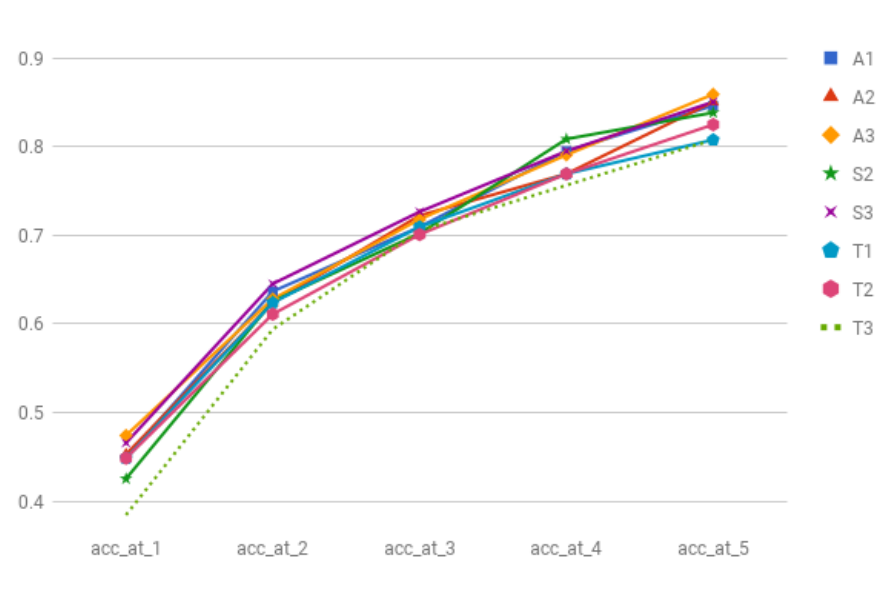
Figure 5. Best results in all the